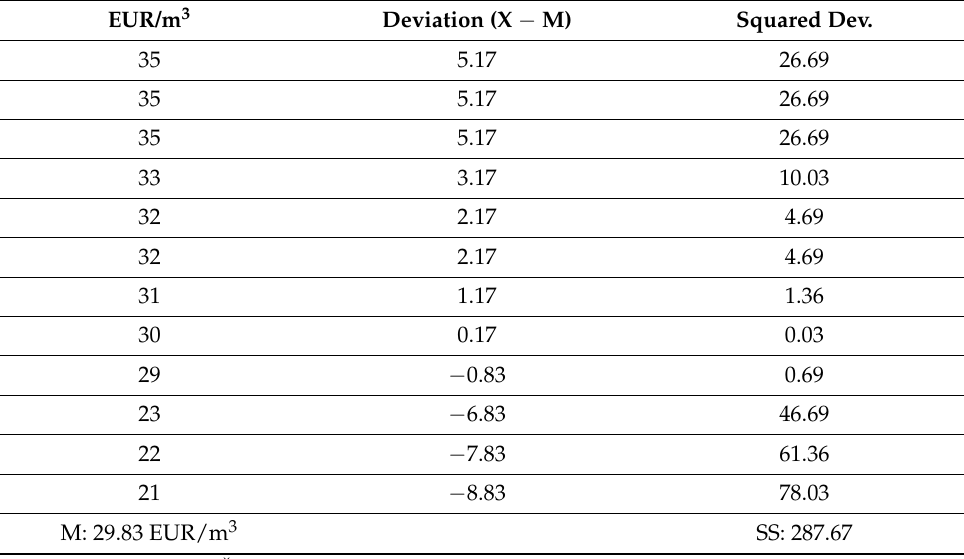
Table 3. Standard Deviation and Variance—The price of